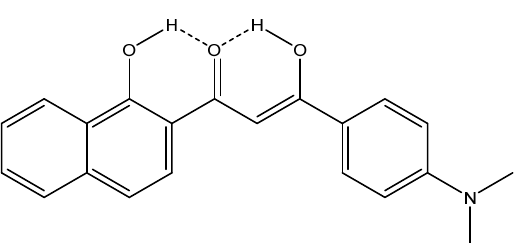
Figure 8. Structure of (Z)-3-(4-(dimethylamino)phenyl)-3-hydroxy-1-(1-hydroxynaphthalen-2- yl)prop-2-en-1-one (DPHND).